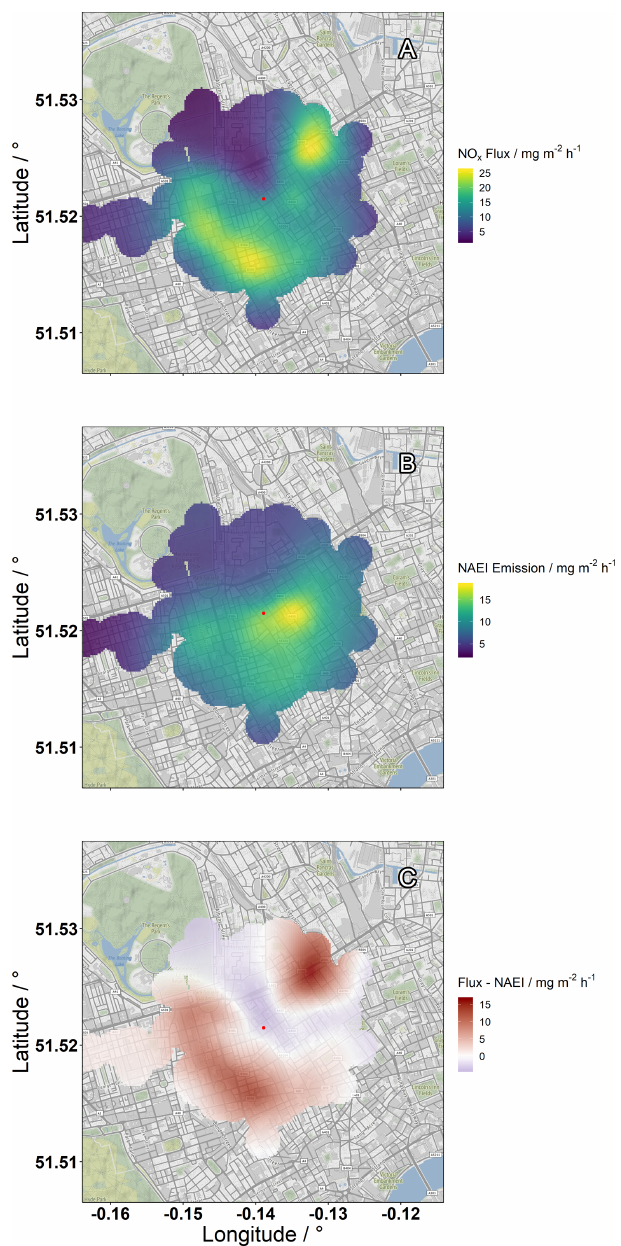
Figure 12. (a) Measured NO x flux as a function of along-wind dis- tance to the maximum flux contribution on the radius, separated by wind direction. (b) NAEI NO x emissions estimate as a function of along-wind distance to the maximum flux contribution on the ra- dius, separated by wind direction. For panels (c–b) subtracted from (a) , red shows measurement greater than inventory, and blue shows inventory greater than measurement. Map tiles by Stamen Design, under CC BY 3.0. Data by OpenStreetMap, under ODbL. Tiles ac- cessed via the ggmap R package (Kahle and Wickham, 2013).